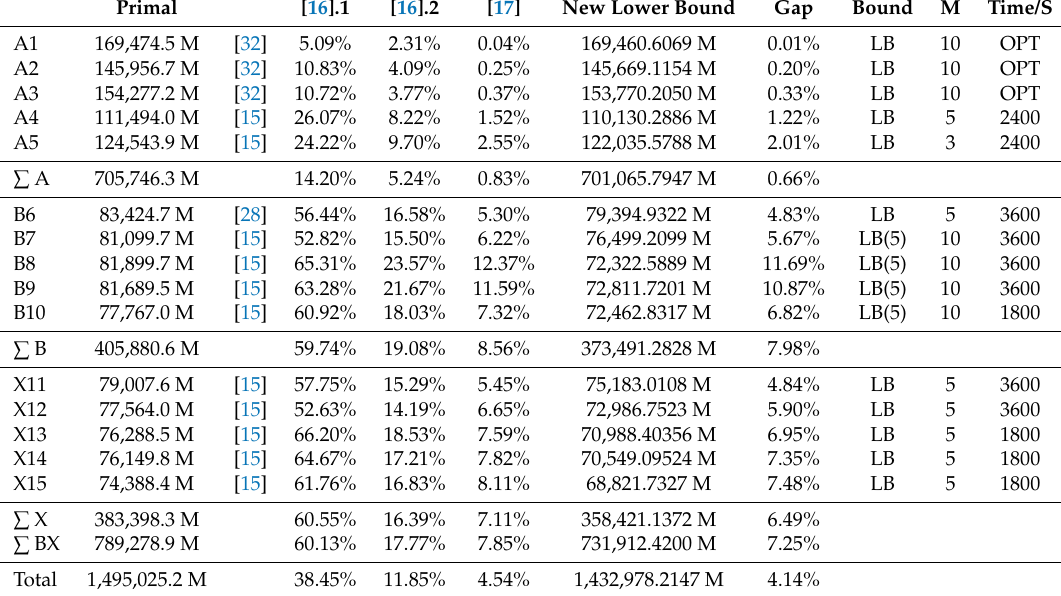
Table 12. New best dual bounds for EURO/ROADEF Challenge 2010, comparison to the former ones of [16,17], and presenting the configuration leading to our best lower bounds. Gaps are calculated for the best primal solution known from [15,28,32]. Machine A is used for instances of datasets B and X, whereas Machine B was used for the instances of datasets